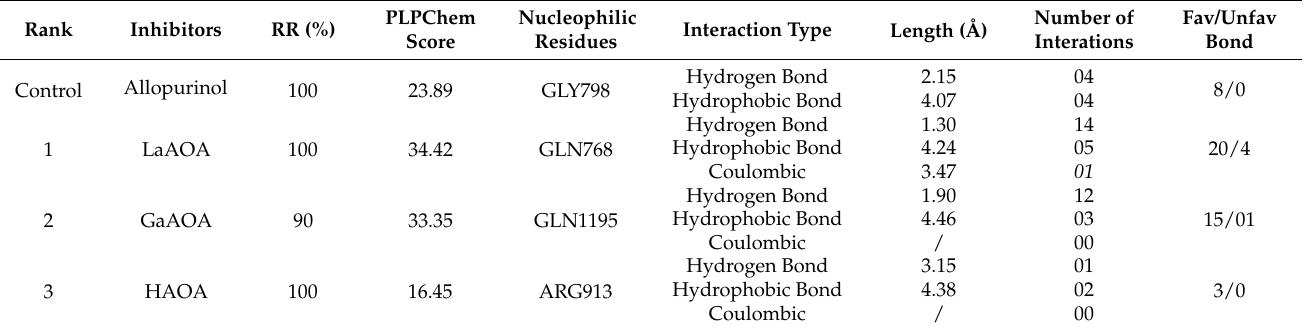
Table 3. The molecular docking results